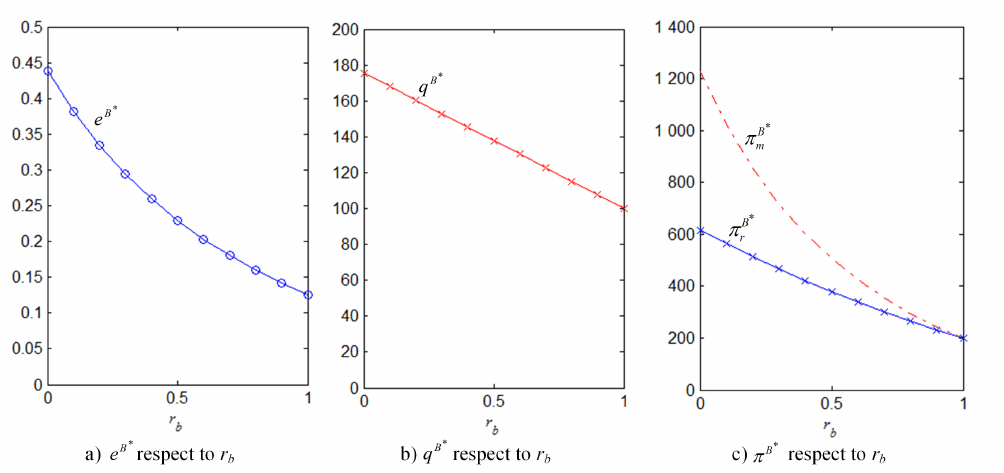
∗ ∗ ∗ ∗ , q B , π B m , π B r with respect to r b ( θ =